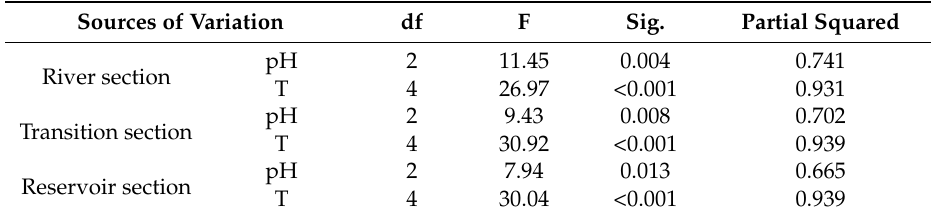
Statistical results of two-way ANOVA on the exchange rate of phosphorus at the sediment-water interface at different sections. Sources of Variation df F Sig. Partial